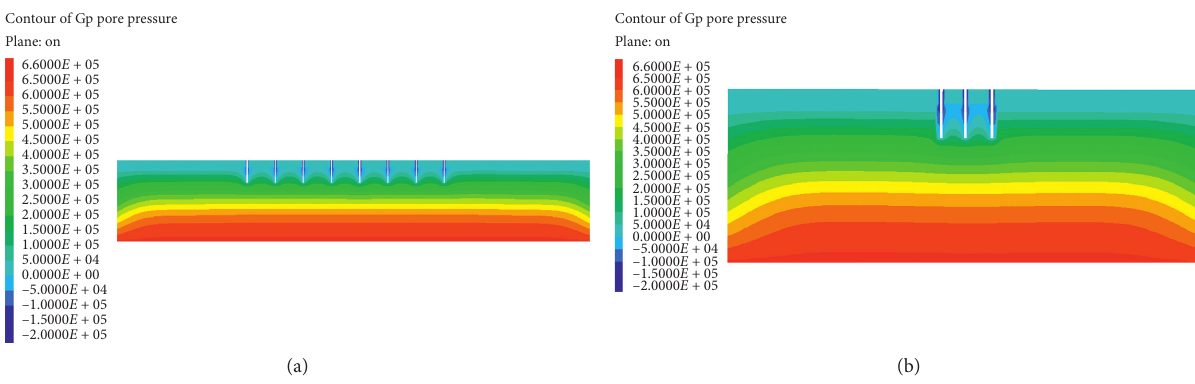
Figure 28: Group wells pore water pressure nephogram after the second drawdown (unit: Pa). (a) Cross section of the well midpoint. (b) Longitudinal section of the well